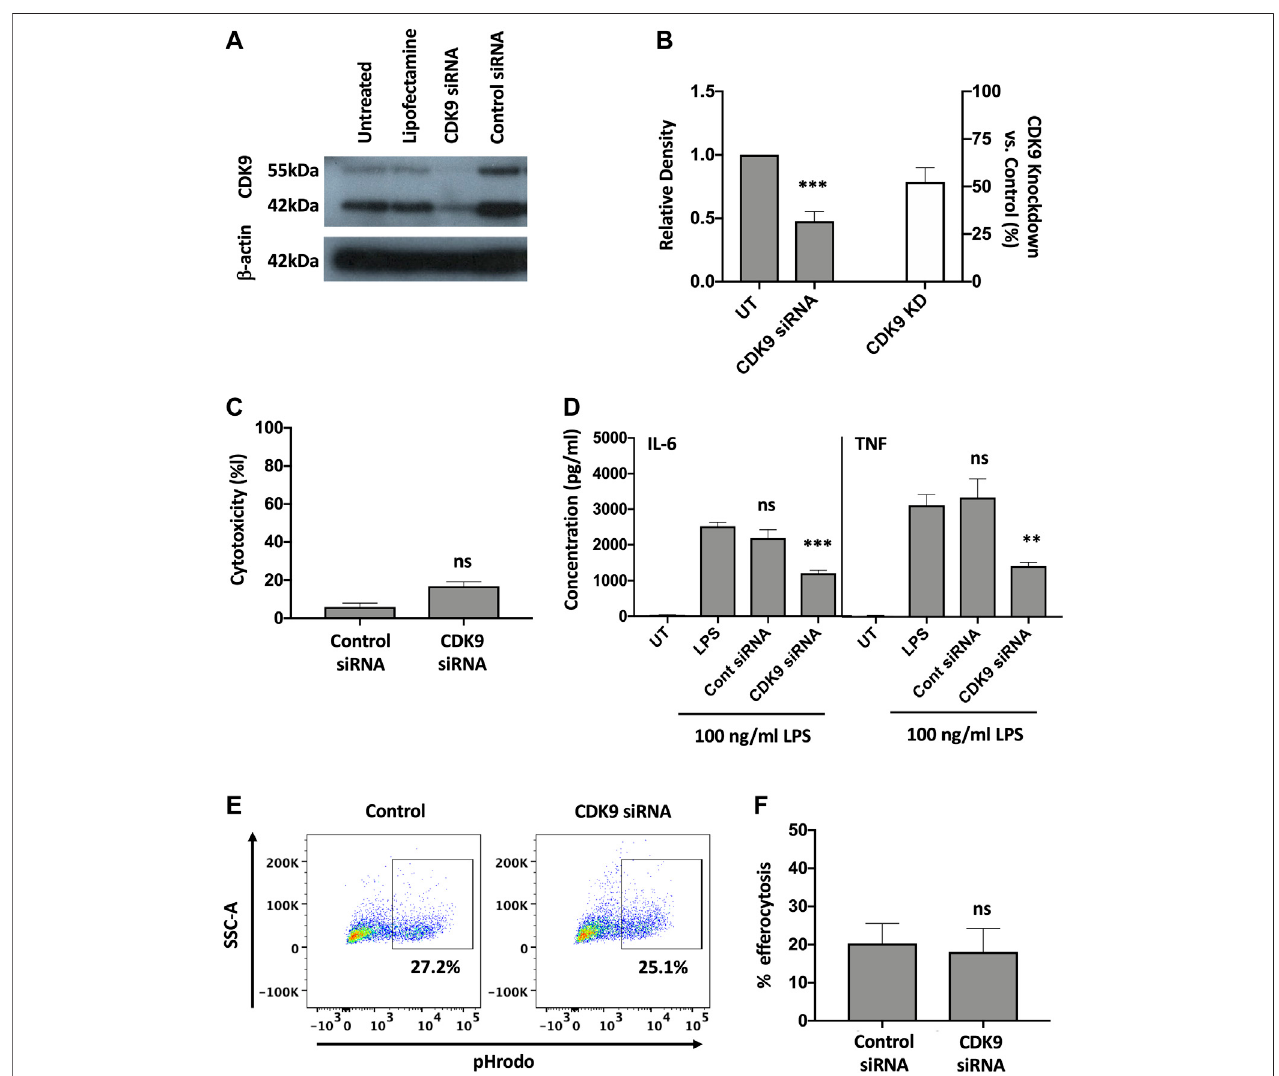
FIGURE 5 | Genetic inhibition of CDK9 attenuates LPS-induced pro-in fl ammatory cytokine release from human MDMs. (A) Western blot of CDK9 protein expression in untreated (UT), lipofectamine-only treated, CDK9 siRNA and control siRNA treated MDMs, compared to Beta-actin as a loading control. Endogenous CDK9 is detected in MDMs as two isoforms of 42 and 55 kDa. (B) The relative expression density of CDK9 in UT versus CDK9 siRNA treated cells as measured by densitometry. (C) Cytotoxicity in control and CDK9 siRNA-treated MDMs as measured by LDH cytotoxicity assay. (D) IL-6 and TNF cytokine release from CDK9 siRNA treated MDMs stimulated with LPS for 24 h compared to controls. (E) Representative fl ow cytometry plots showing efferocytosis of pHrodo labelled apoptotic neutrophils in CDK9 siRNA-treated compared to control siRNA-treated MDMs. (F) Collated levels of efferocytosis from all donors tested, comparing control siRNA- treated and CDK9 siRNA-treated MDMs. Data represent means ± SEM from n = 6 separate donors, * p < 0.05 ** p < 0.01 *** p < 0.001. ns = no signi fi cant difference.